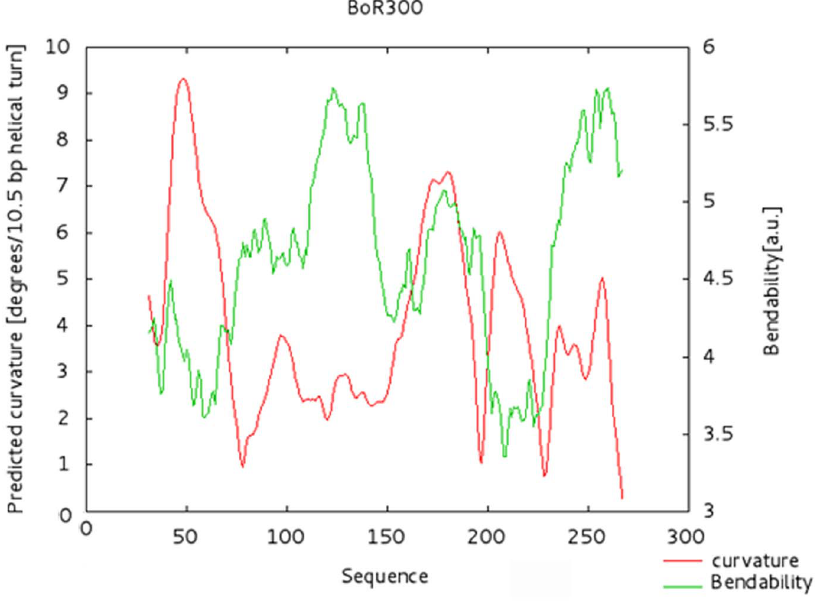
Figure 4. Curvature analysis of BoR300. Curvature-propensity plot of the consensus sequence of BoR300 showing that the maximum peak is located at the beginning of the monomer (red line).